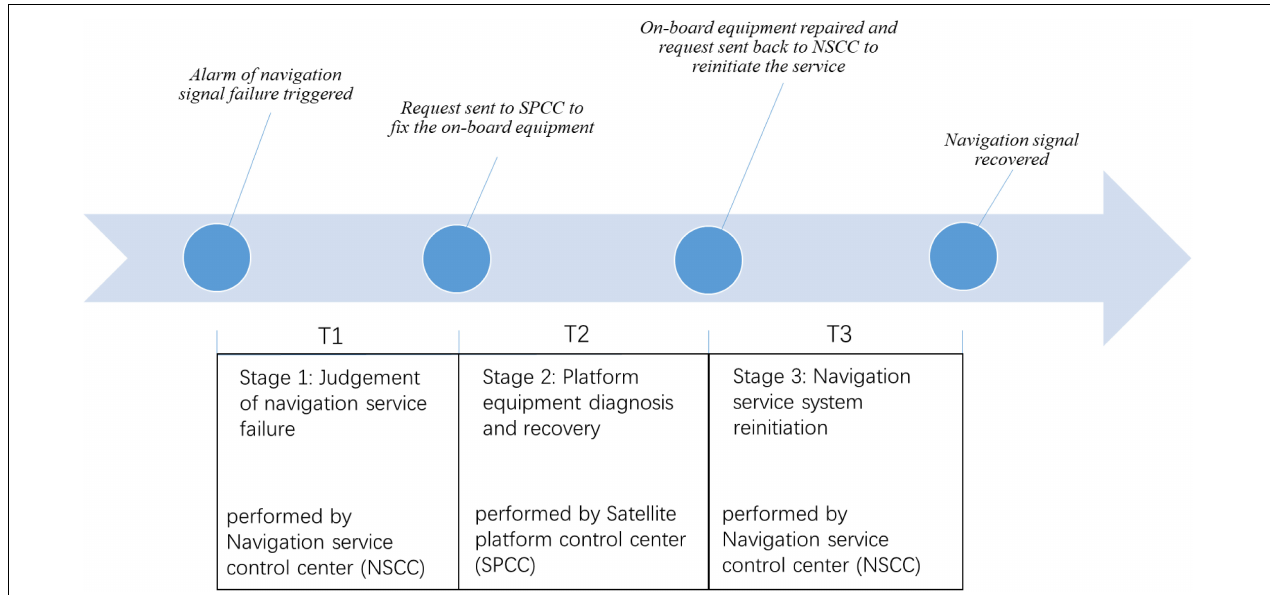
FIGURE 1 | The four critical events (the circles) and the three stages of operations of an instrument failure handling process.